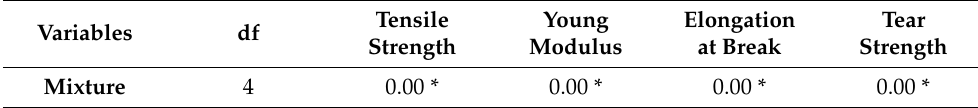
Tensile Young Elongation Tear Strength Modulus at Break Strength